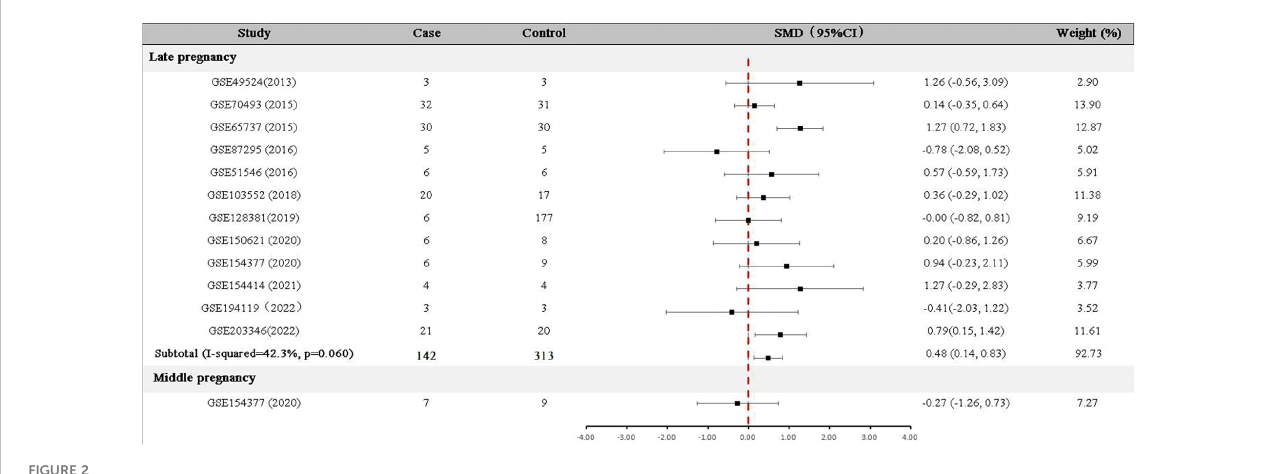
TABLE 2 Characteristics of GDF-15 protein expression pro fi ling datasets included in the current meta-analysis between GDM and controls.